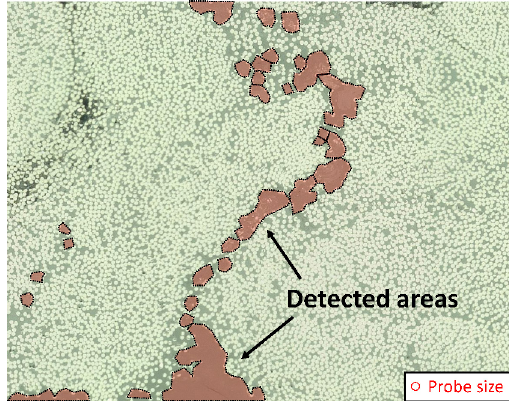
Fig. 3 Fiber-deficient areas detected by our algorithm, using as input the microscope image shown in Fig. 1(a). The probe radius used here is the mode of the detected fiber